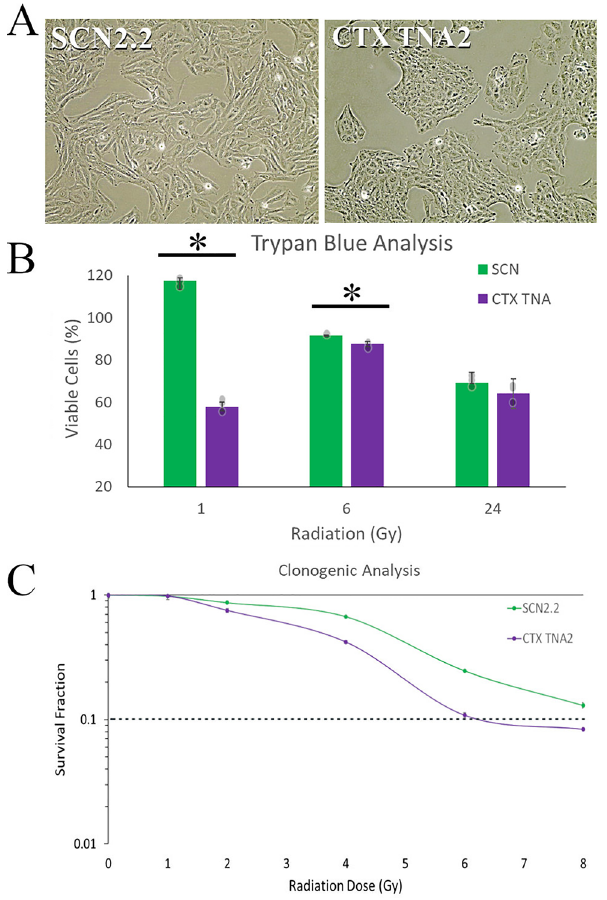
Figure 4. In vitro radiosensitivity of astrocytic cell lines based on region of isolation and treatment timing. ( A ) Photomicrographs of SCN2.2 and CTXTNA2 cells, two astrocytic cell lines with similar morphology. B. Quantification of trypan blue postitive cells to determine cell viability 1, 6 and 24 h after 8 Gy radiation, there were significant main effects for time (F(1,18) = 96.834, p < 0.001), cell type (F(1,18) = 235.937, p < 0.001), and an interaction between time and cell type (F(2,17) = 151.927, < 0.001). Posthoc tests (tukey) were significant if p < 0.05. SCN2.2 cells (green bars) survived at significantly higher level 1 ( p < 0.001) and 6 h ( p = 0.024) after radiation when compared to the cortical astrocytes (purple bars). ( C ) Clonogenic assay to quantify survival fractions from 0 to 8 Gy in SCN and cortical cells. Again SCN2.2 cells (green line) had better overall survival after radiation when compared to CTXTNA2 cells (purple line). There were significant main effects of both cell line (F(1,24) = 33.228, p < 0.001) and radiation dose (F(5,24) = 402.558, p < 0.001), and an interaction between cell line and dose (F(5,24) = 6.172, p = 0.001). The dotted black line across the graph shows the dose modifying fractors